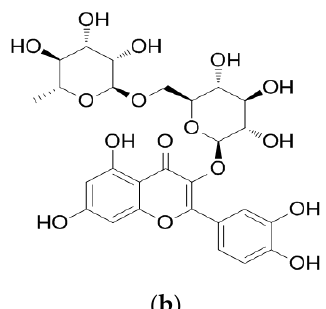
Group 3: Diabetic control Group 4: Diabetic + Apig- enin mmol/L glu- cose, respec- tively